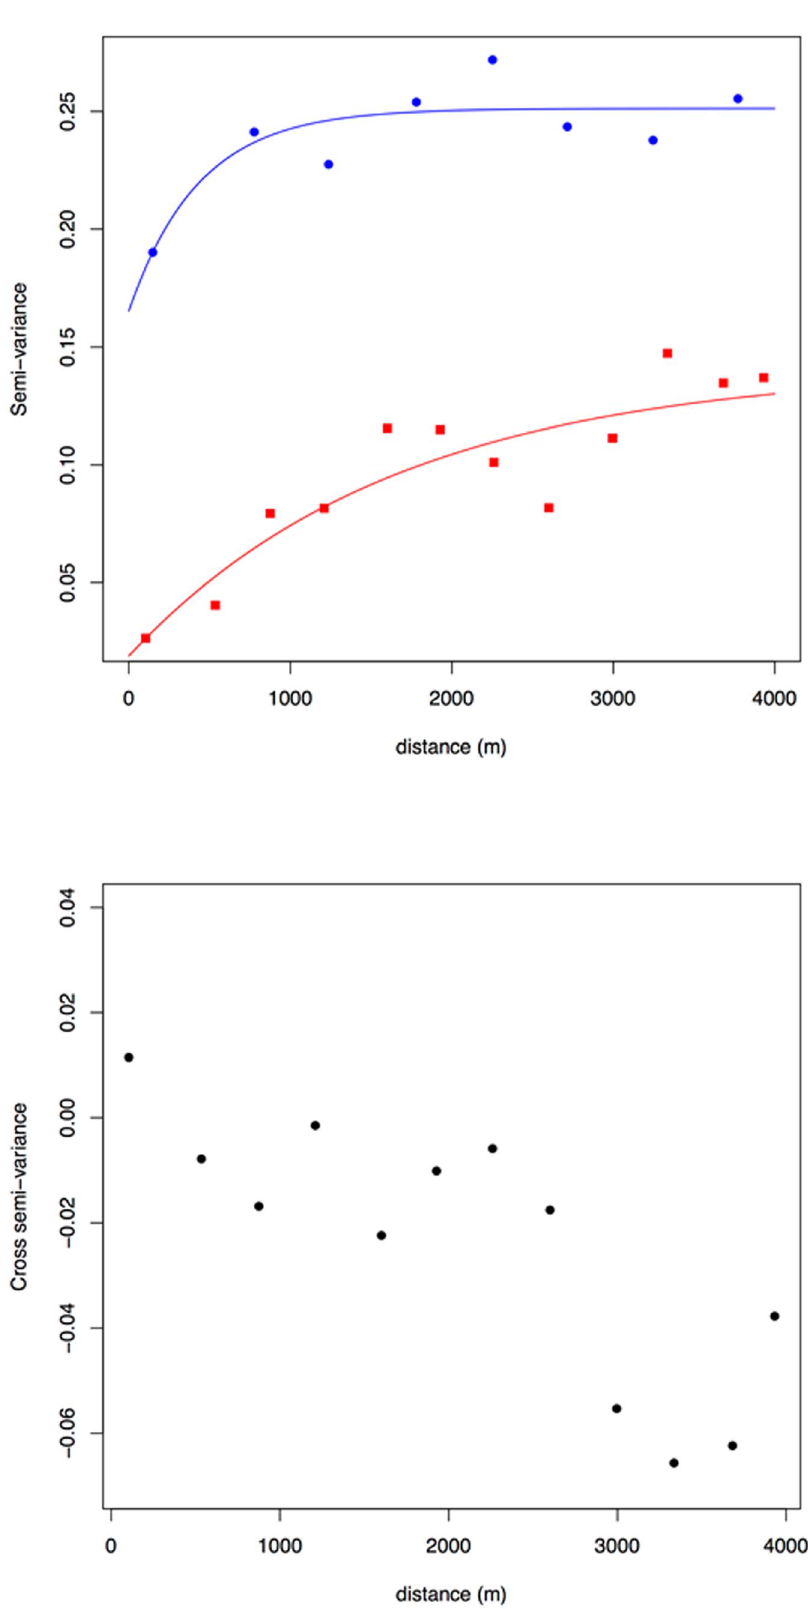
Figure 3. Geostatistical analysis of M.natalensis and R.rattus spatial distributions across the city of Niamey, Niger. (a) Indicator variograms for a threshold value Z k =0. Blue circles and red squares indicate empirical variograms for M. natalensis and R. rattus , respectively. Solid lines correspond to fitted exponential variogram models. (b) Cross indicator variogram for M. natalensis and R. rattus with a threshold value Z k =0. doi:10.1371/journal.pone.0110666.g003 PLOS ONE |